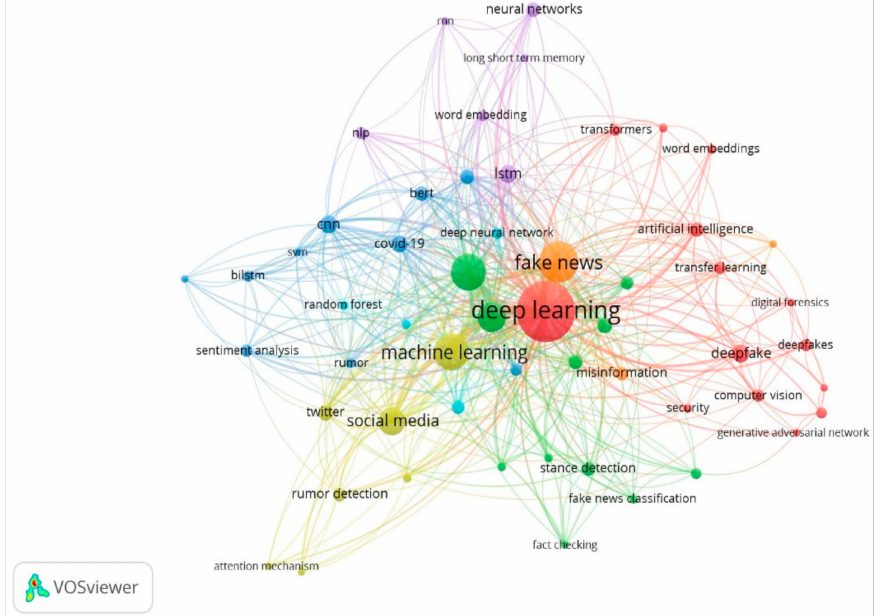
Figure 17. Keyword co-occurrence